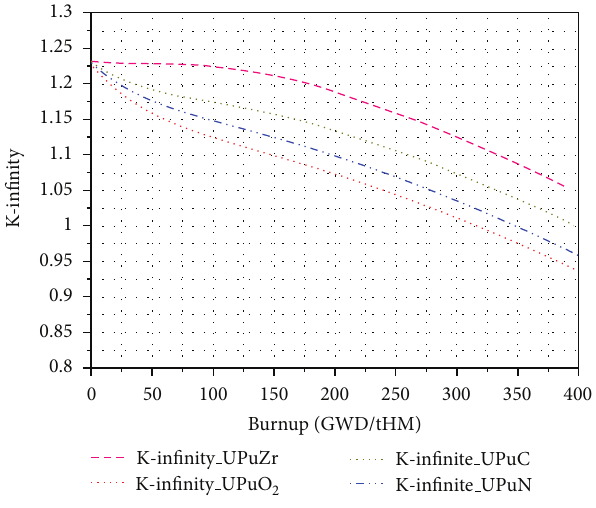
Figure 1: Reactivity versus burnup for typical fuel materials.